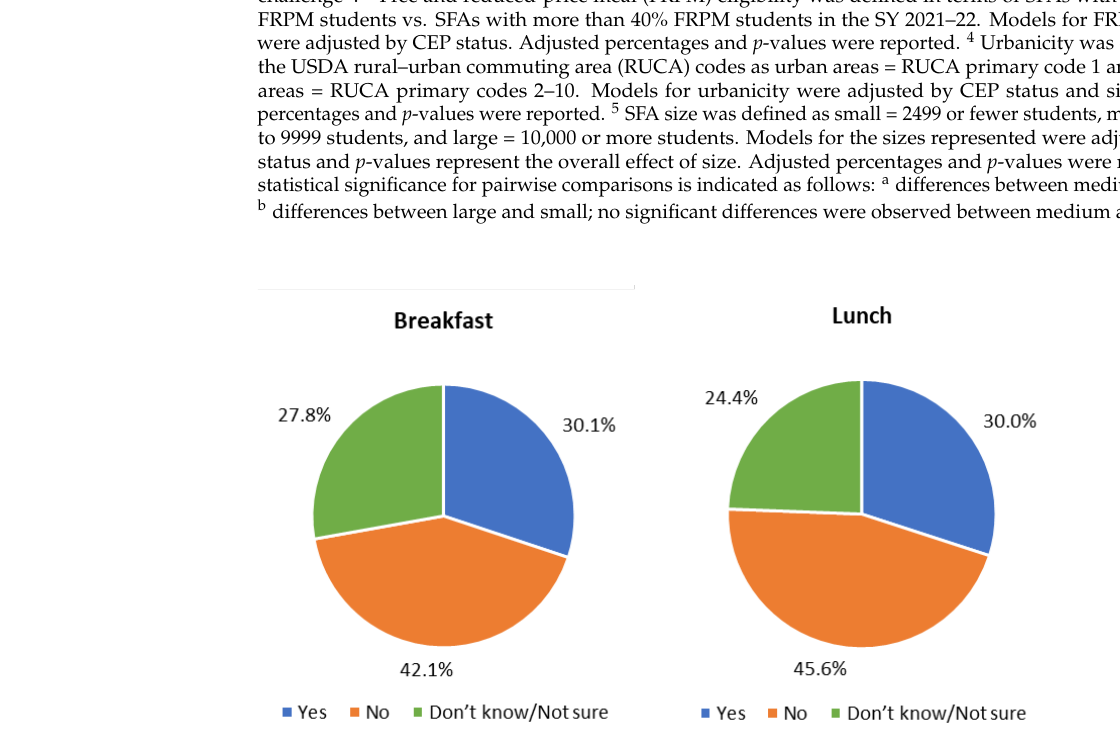
Figure 4. Responses by Californian school food authorities to the survey question: “Is the current meal reimbursement sufficient to cover the full cost of producing meals?” ( n = 572 for breakfast n = 574 for lunch; response options included “yes”, “no”, and “don’t know/not sure”). Stratified analyses found no statistically significant differences between the percentage of SFAs that reported that the current meal reimbursement is sufficient to cover the full cost of producing school breakfast and urbanicity, size, and FRPM eligibility (Supplementary Table S3). SFAs with a higher proportion of students eligible for FRPMs (>40%) reported that the current reimbursement is enough to cover the cost of producing school lunch more often than those with lower FRPM eligibility (43.3% vs. 31.0, respectively; p = 0.02). There was no statistically significant difference by urbanicity or size that was related to the percentage of SFAs that reported that the current meal reimbursement is not sufficient to cover the full cost of producing school lunches ( p >